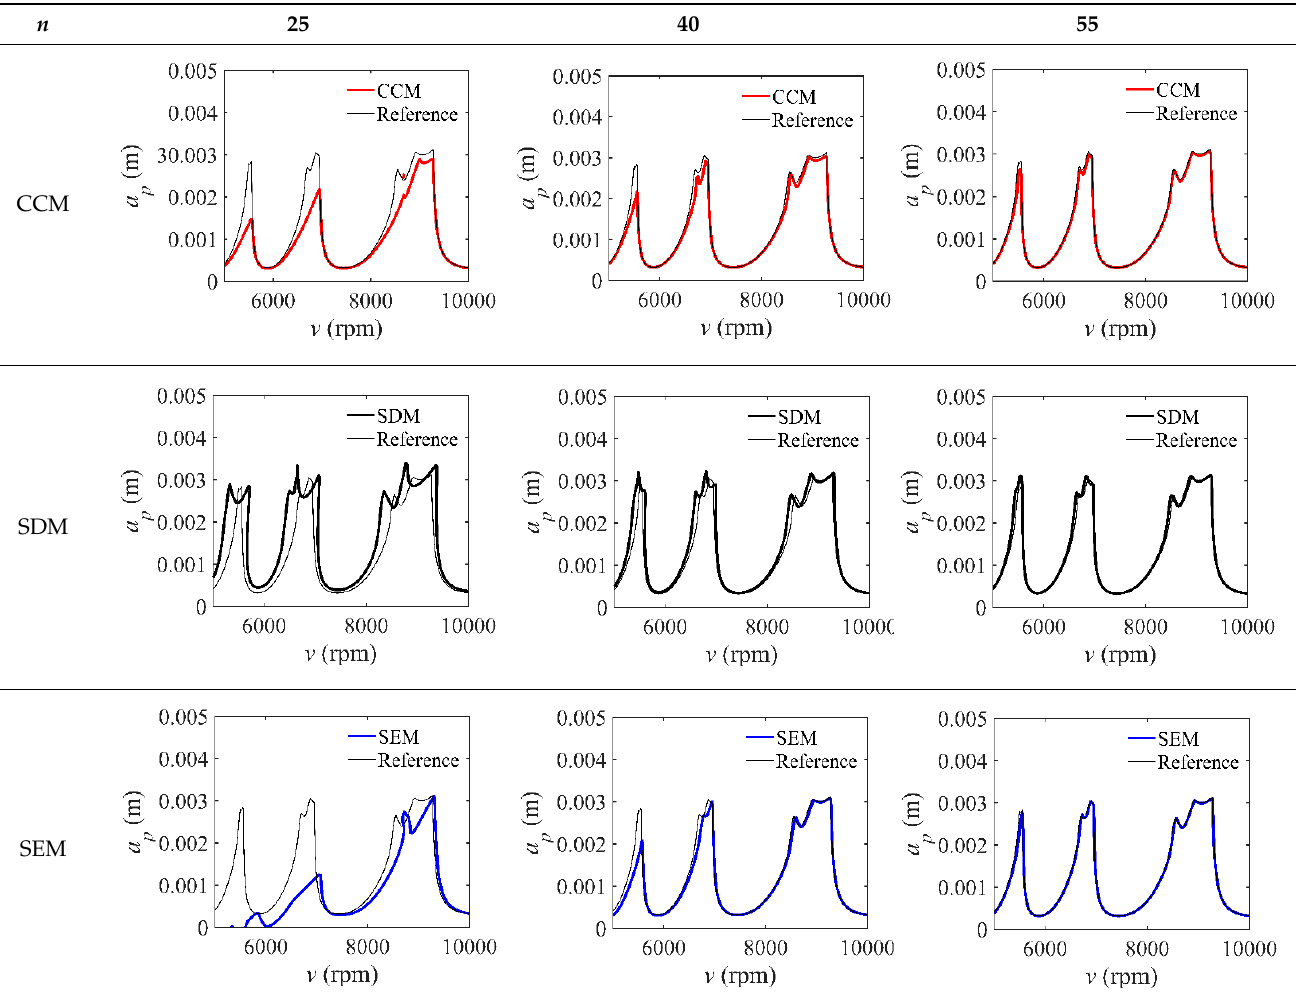
Table 1. Stability lobe diagrams of the CCM, SDM, and SEM when a / D = 1.